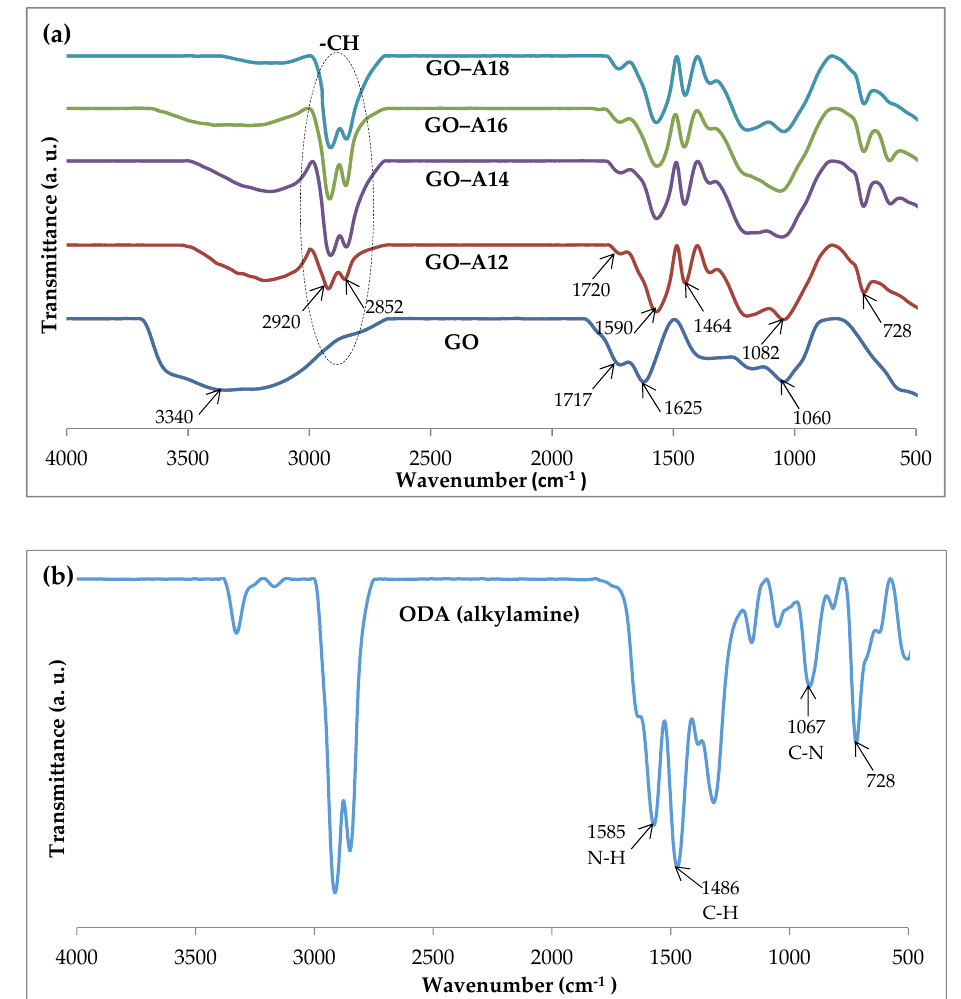
Figure 2. FTIR spectra of ( a ) GO and functionalized GO; and ( b ) octadecylamine (ODA).